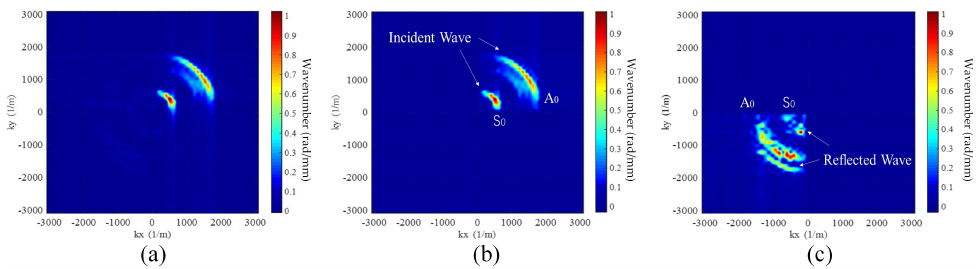
Figure 6. Wavenumber domain information and window function are used to separate incident and reflected waves. ( a ) Original wavenumber domain information. ( b ) The incident wavefield. ( c ) The reflected wavefield.